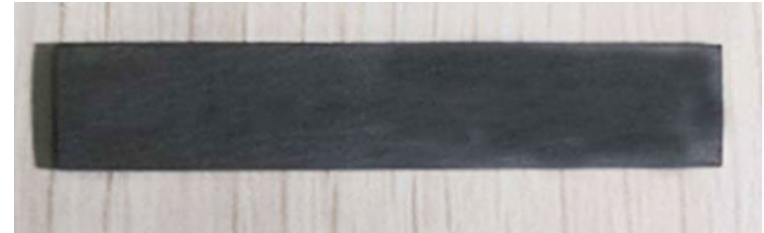
Figure 2. EMC samples for DMA test.